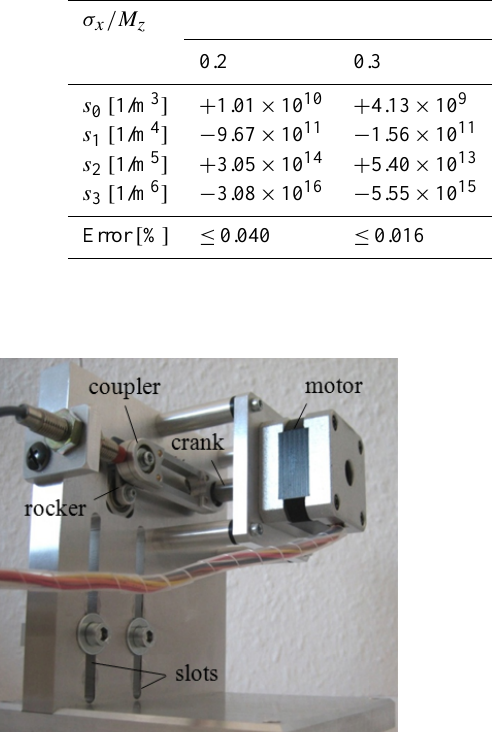
Table 1. Polynomial coefficients and fitting errors for the stress factor σ x /M z .